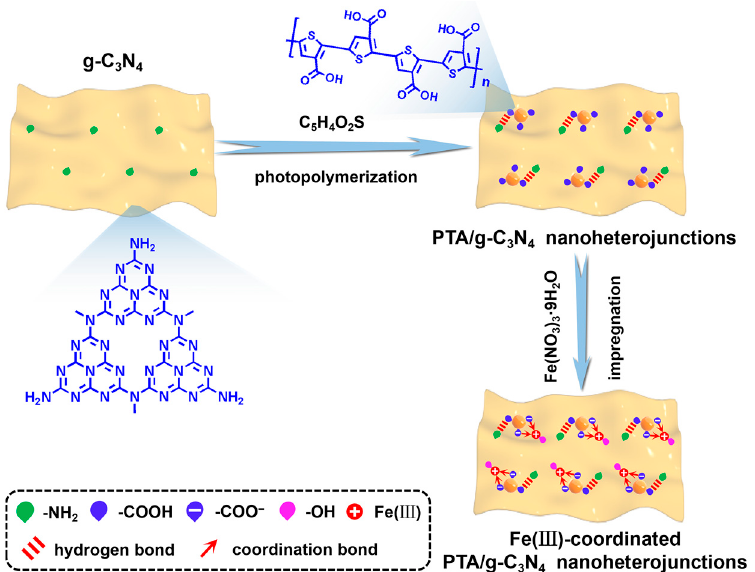
Figure 1. Schematic diagram of Fe(III)-coordinated PTA/g-C 3 N 4